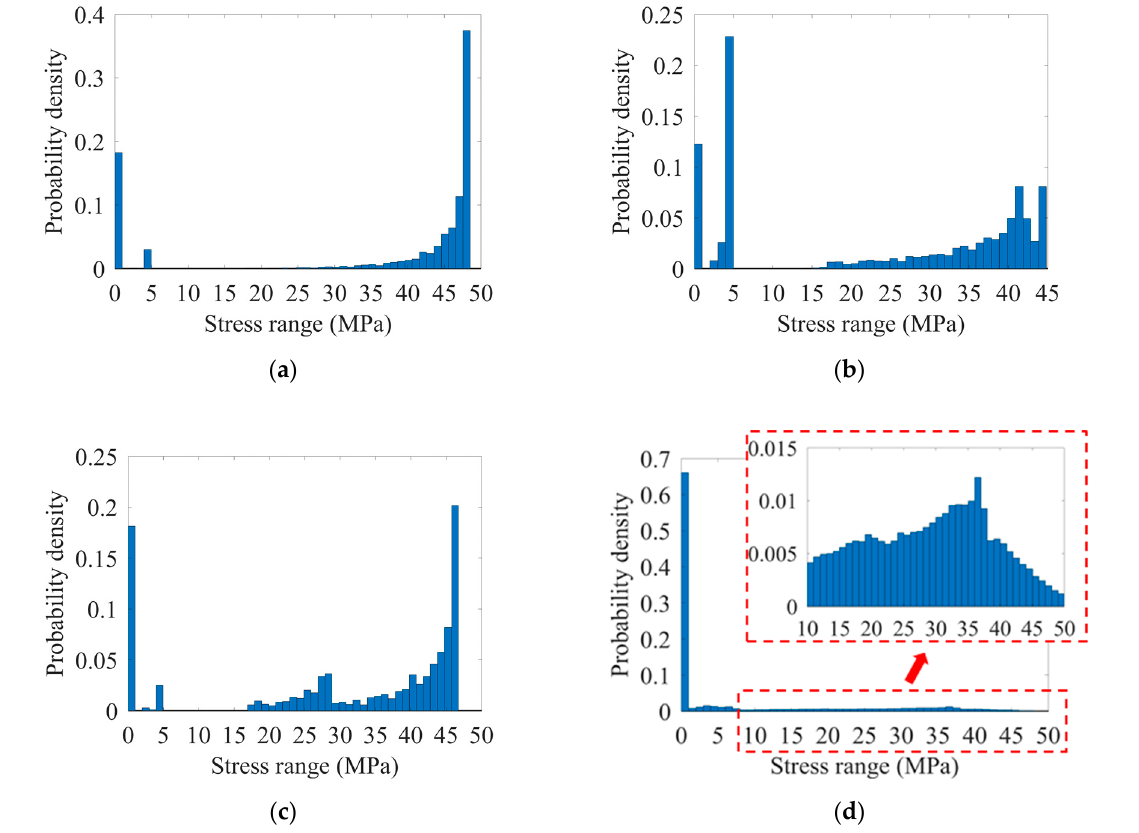
Figure 15. Hot spot stress spectra of the joint U12 L solved by different traffic models: ( a ) JTG; ( b ) EC1; ( c ) AASHTO; ( d ) Observation model.